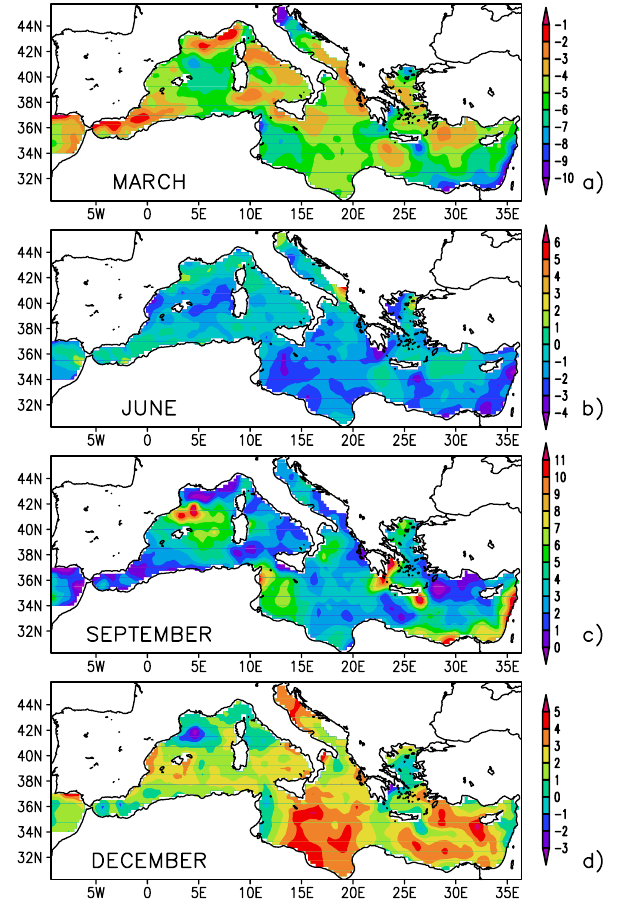
Fig. 12. Sound speed monthly deviation (m/s) at 50m in March (a) , June (b) , September (c) and December (d)